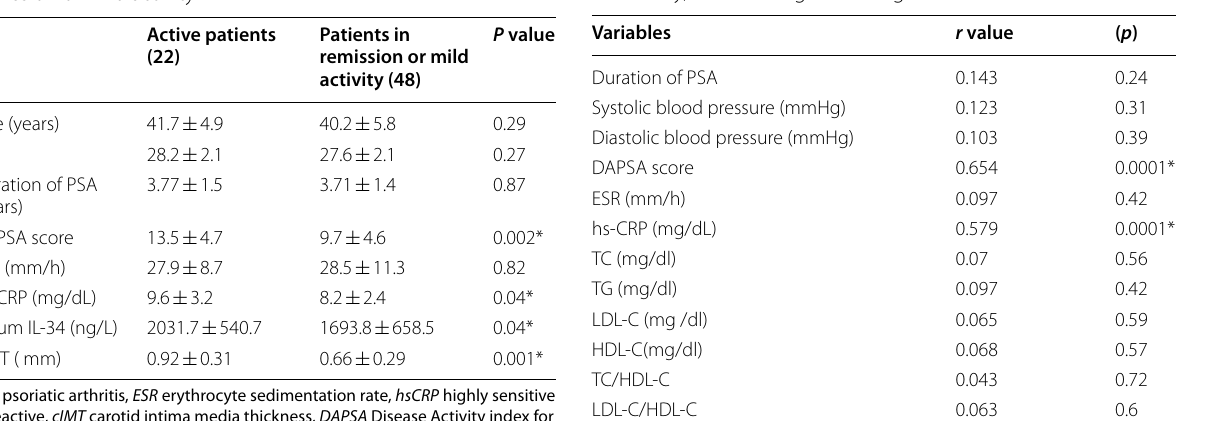
Table 4 Correlation between serum IL‑34 and different clinical, laboratory, and radiological